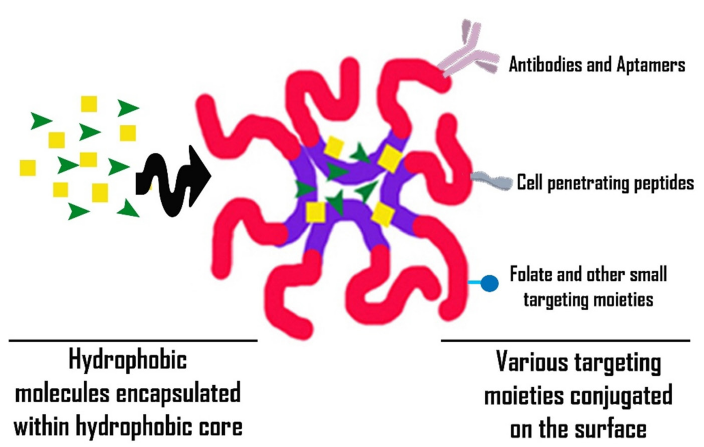
Fig. 1. Pluronic based delivery system; a novel platform for formulation of hydrophobic molecules and targeted delivery